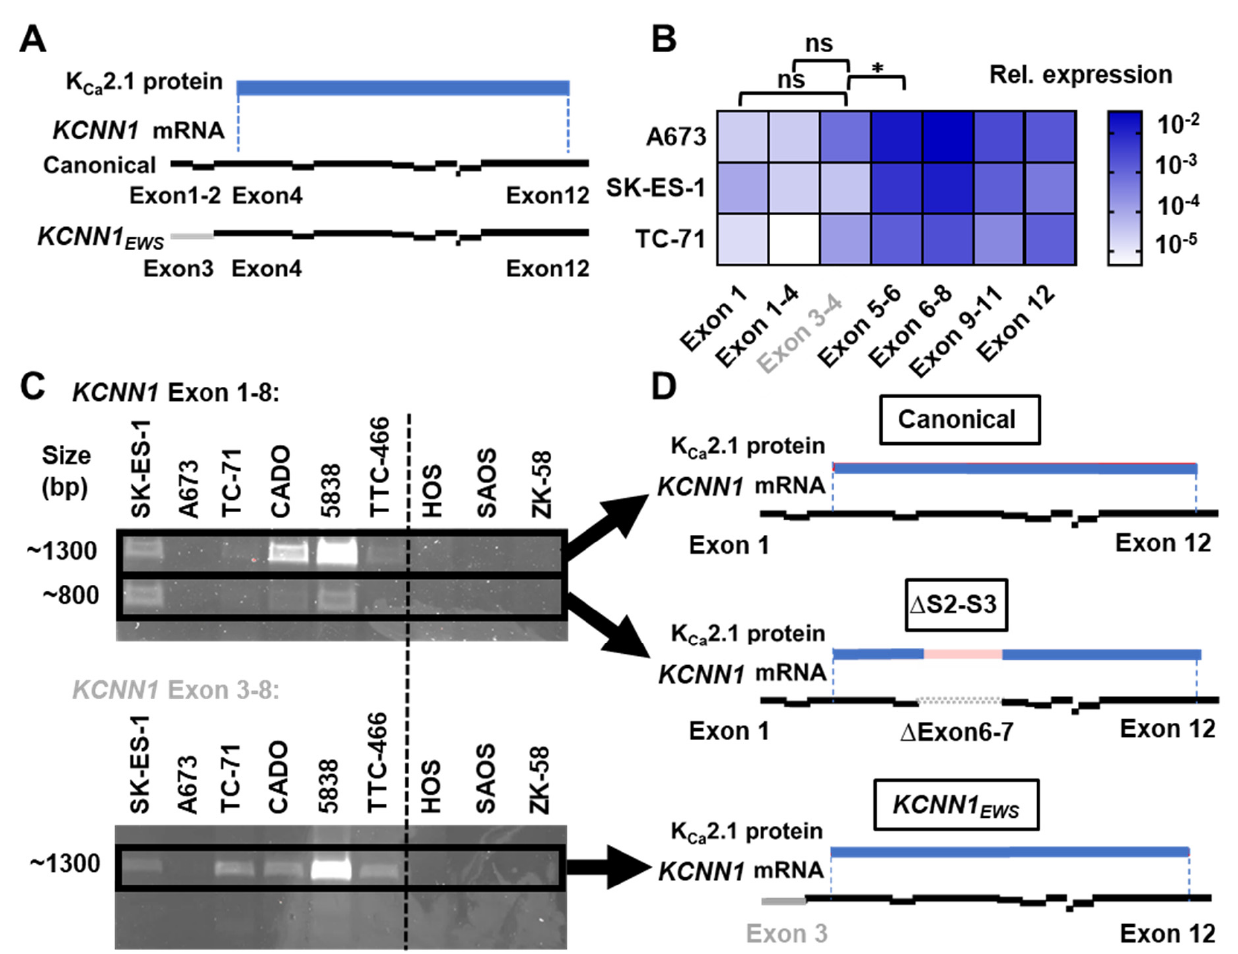
Figure 3. Detection of the KCNN1 EWS transcript. ( A ) Schematic visualization of KCNN1 transcription and translation. Exon 1–2 (black) and 4–12 correspond to the canonical transcript (NM_002248), whereas alternative transcript (NM_0011386975) expresses exon 3 (grey)-12. Dashed lines represent the start and the end of the open reading frame, and blue line represents the resulting K Ca 2.1 channel protein. ( B ) Heatmap shows quantification of KCNN1 exon expression in EwS cell lines A673, SK-ES-1 and TC-71, with color code on the right. N = 3 different EWS cell line passages with a total of n = 14 replicates per data point. * p < 0.05. ( C ) Representative polyacrylamide gels derived from RT-PCR of the canonical transcript (top, exon 1–8) and the alternative transcript (bottom, exon 3–8). Dashed line separates EwS cell lines ( left ) from OS cell lines ( right ). N = 3 different EWS cell line passages with n = 3 technical replicates. ( D ) Illustration—explained in ( A )—shows KCNN1 mRNA sequences derived by capillary sequencing from transcripts highlighted in ( C ) with bold rectangles. Full PCR gel images can be found at Supplementary